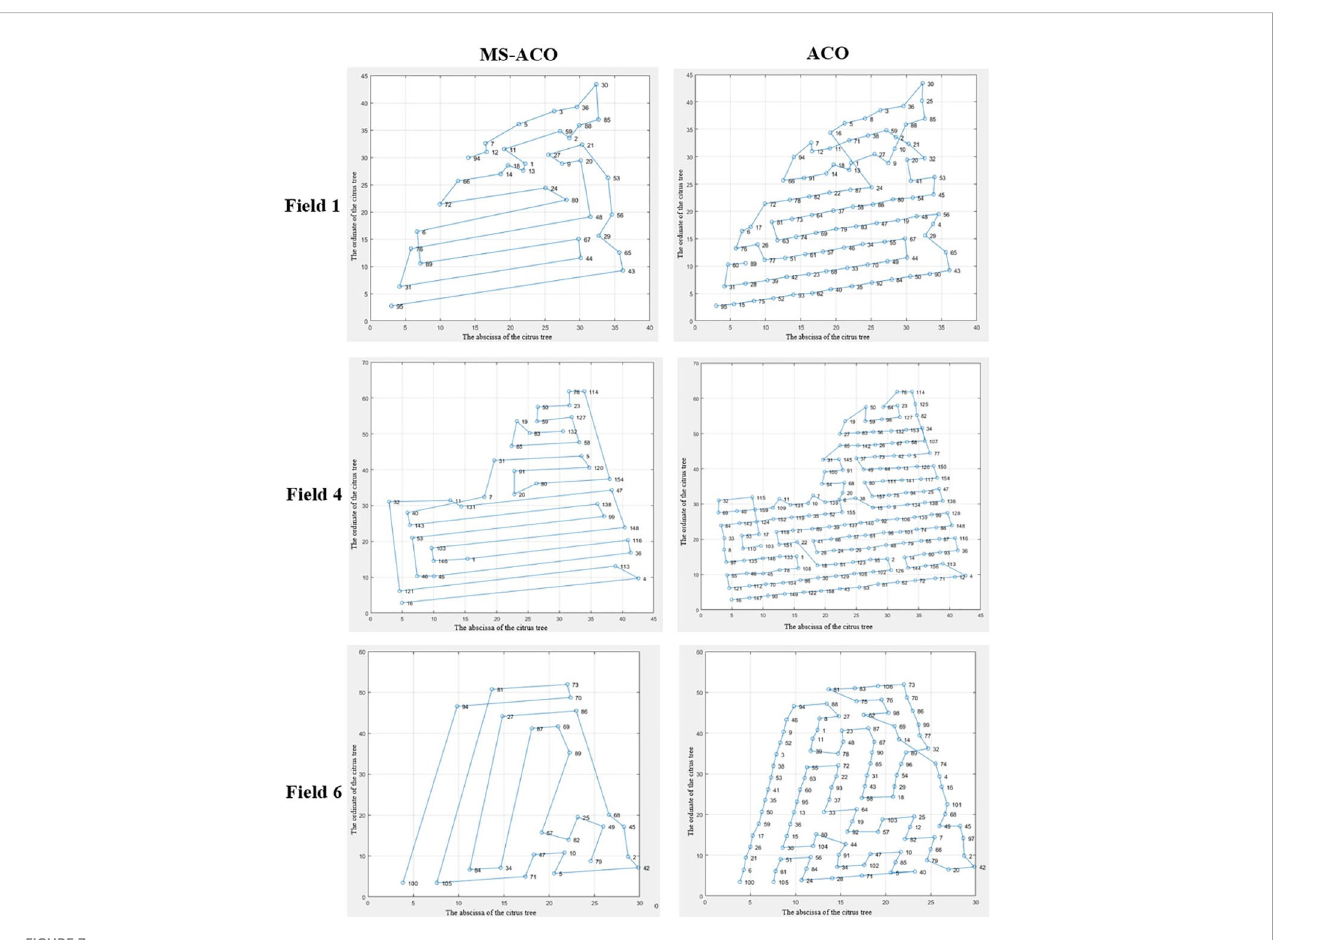
FIGURE 7 Comparison of the best paths for MS-ACO and ACO solutions.